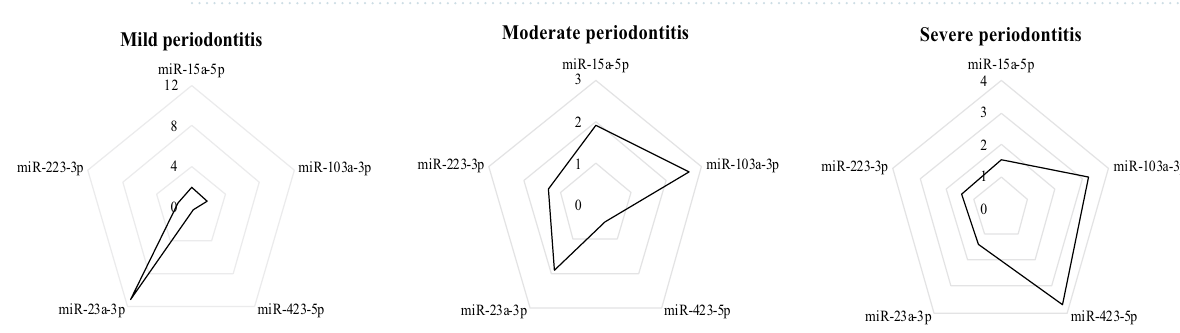
Figure 3. Radar plot of relative miRNAs expression profiles according to periodontitis